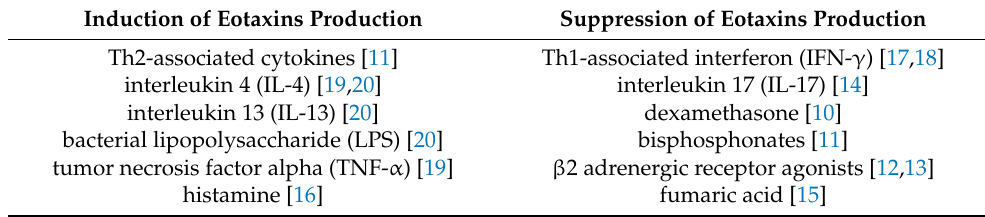
Table 1. Inflammatory mediators which control the production of eotaxins